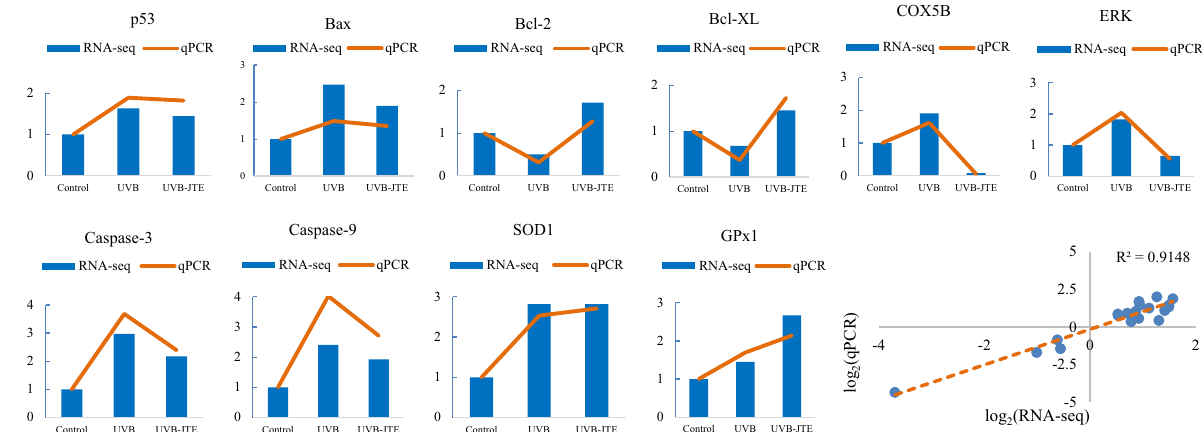
Fig. 4 The genes associated with apoptosis pathway were selected for the quantitative real-time PCR (qPCR) analysis. The genes expressions of UVB and UVB-JTE were normalized to normal control, and GAPDH gene was chosen as the endogenous control for qPCR. p53: tumor protein p53; Bax: apoptosis regulator Bax; Bcl-2: apoptosis regulator Bcl-2; Bcl-XL: apoptosis regulator Bcl-XL; COX5B: Cytochrome c oxidase subunit 5B; ERK: mitogen-activated protein kinase 1/3; SOD1: superoxide dismutase; GPx1: glutathione